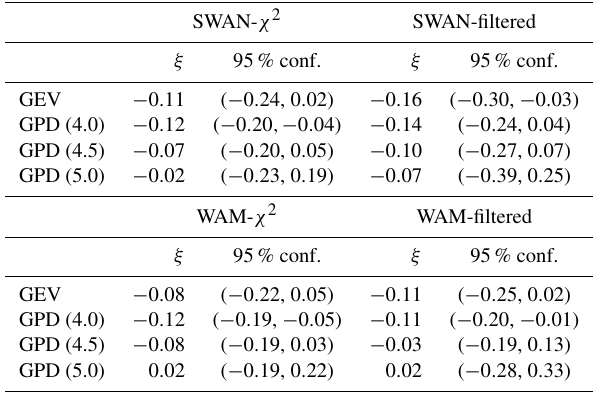
Table 2. The shape parameters, ξ , of GEV and GPD fits to annual maxima an POT data, where GPD (4.0) denotes a u = 4 . 0m thresh- old for the POT. A negative value of ξ means a thin-tailed distribu- tion. For a description of the data sets (e.g. WAM- χ 2 ), see Table 1.